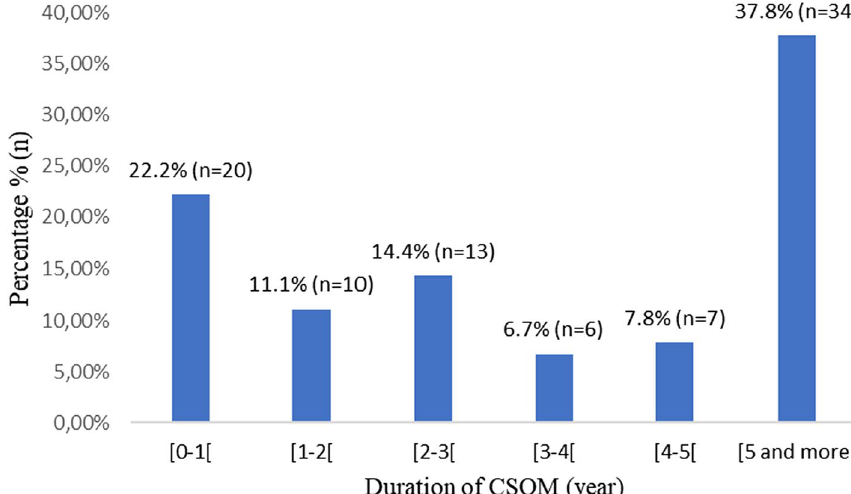
Fig. 2 Distribution of cases according to the duration of